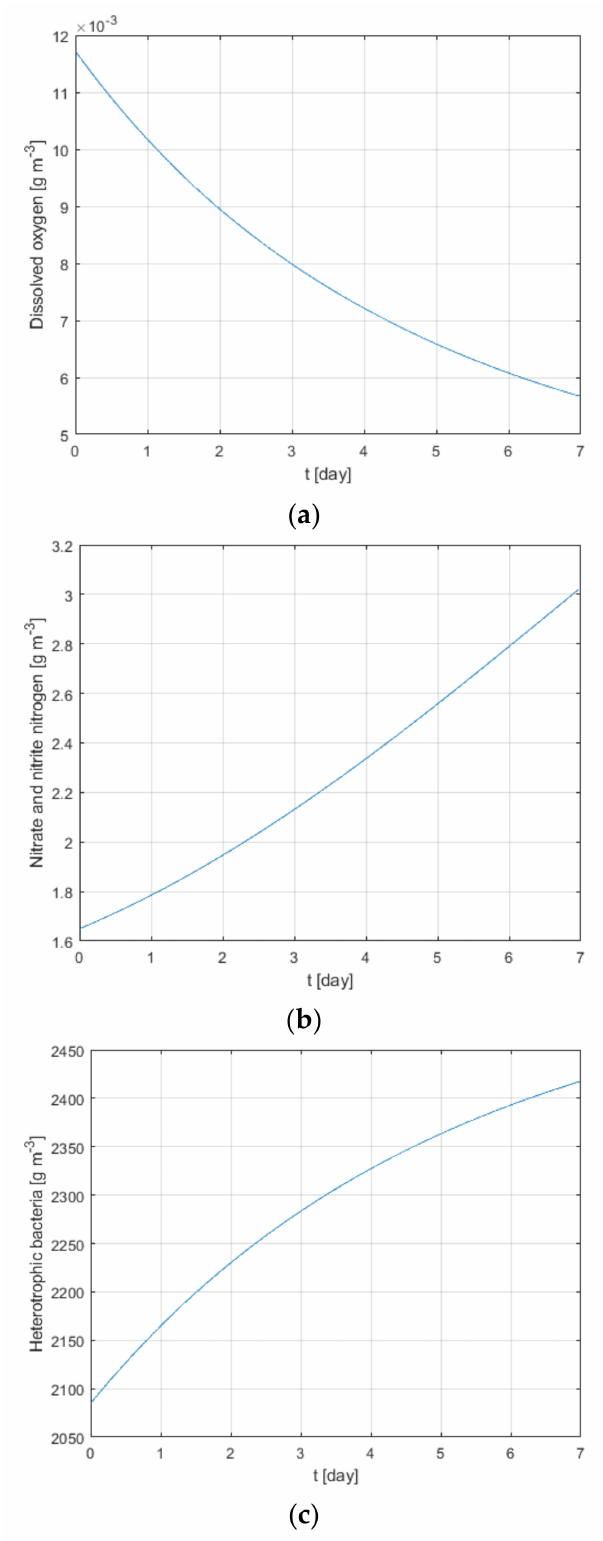
Figure 4. Dissolved oxygen ( a ), nitrate and nitrite ( b ), and heterotrophic bacteria ( c ) in the first anoxic